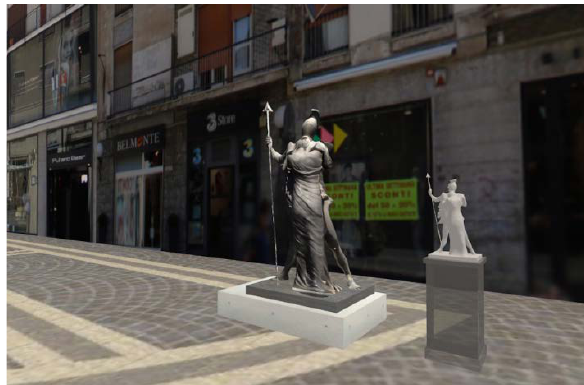
Figure 20. The models of Hector and Andromache and of the miniature in the new location.